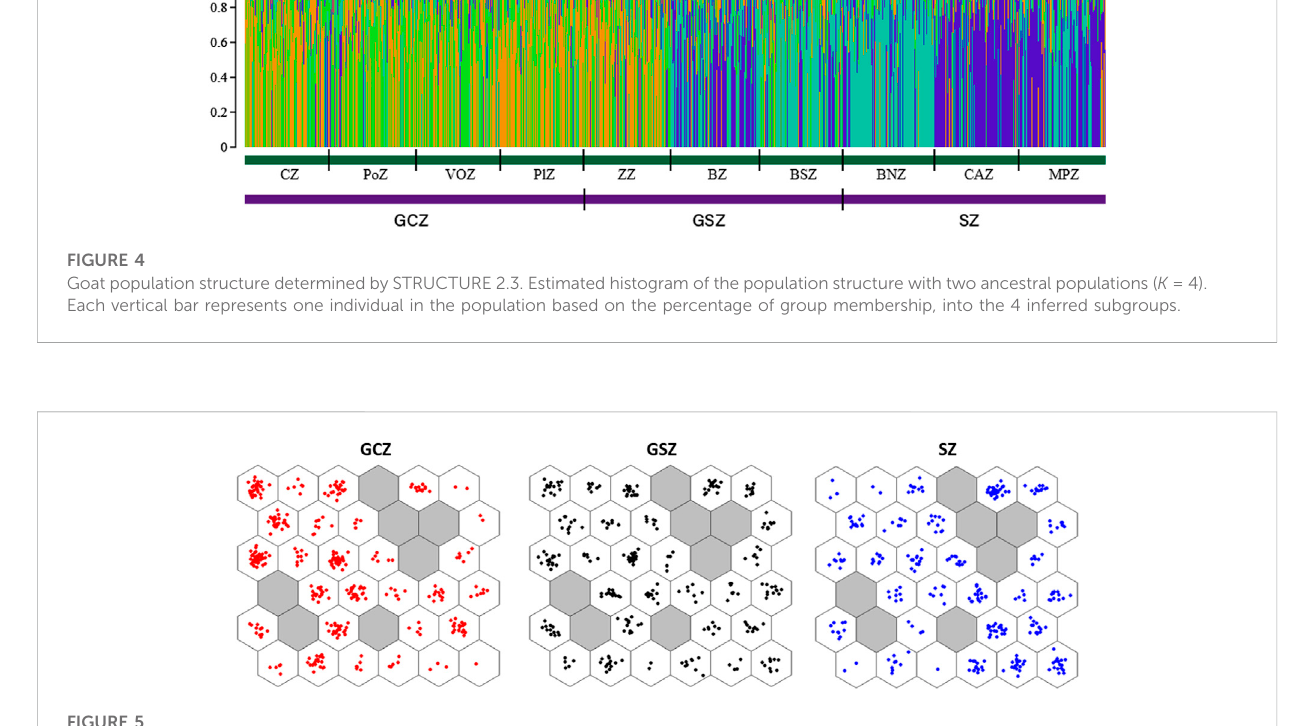
FIGURE 5 Distribution of the genotyped goats on the SOM network according to the assignment of each of the vegetation zone groups. Each colored dot corresponds to a goat individual. The plots express individual ’ s assignment by emphasizing vegetation zone models where GCZ: Guineo-Congolese zone, GSZ: Guineo-Sudanian zone, and SZ: Sudanian